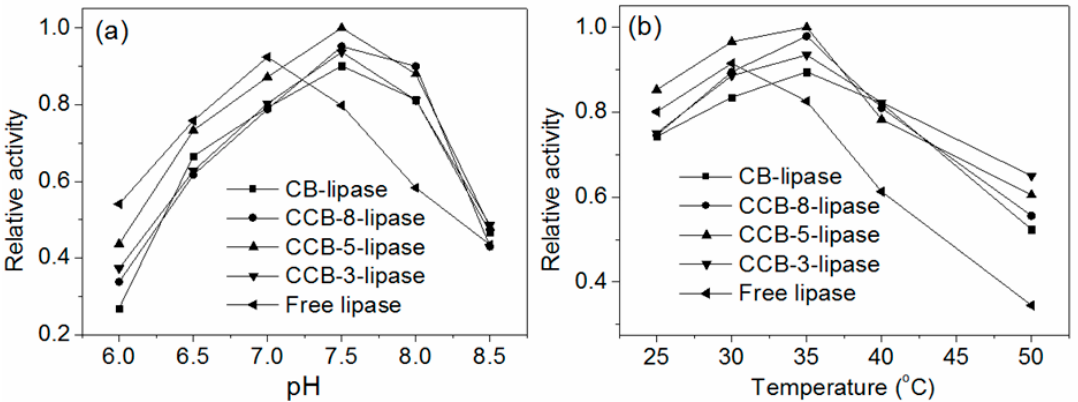
Figure 4. Effect of pH ( a ) and temperature ( b ) on the activity of immobilized lipase. Substrate concentration: 0.18 g/mL, 0.2 g immobilized beads.